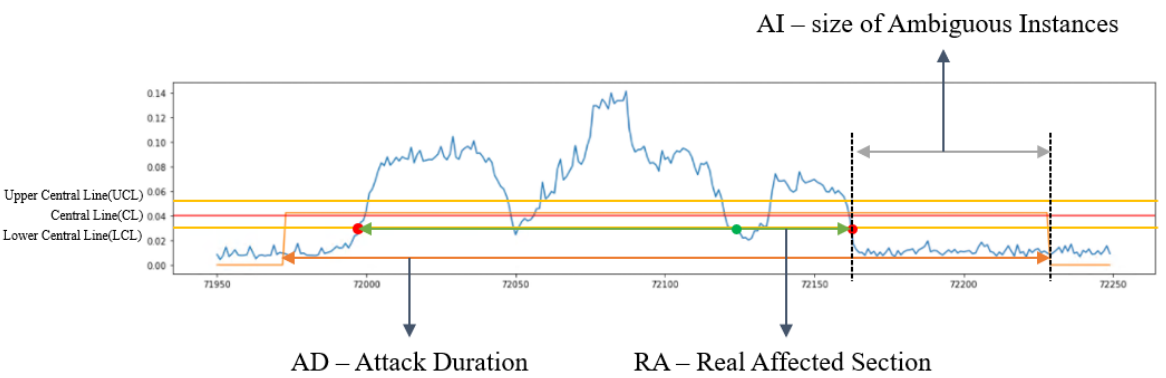
Figure 16. An example of an ambiguous section obtained by applying the proposed algorithm.